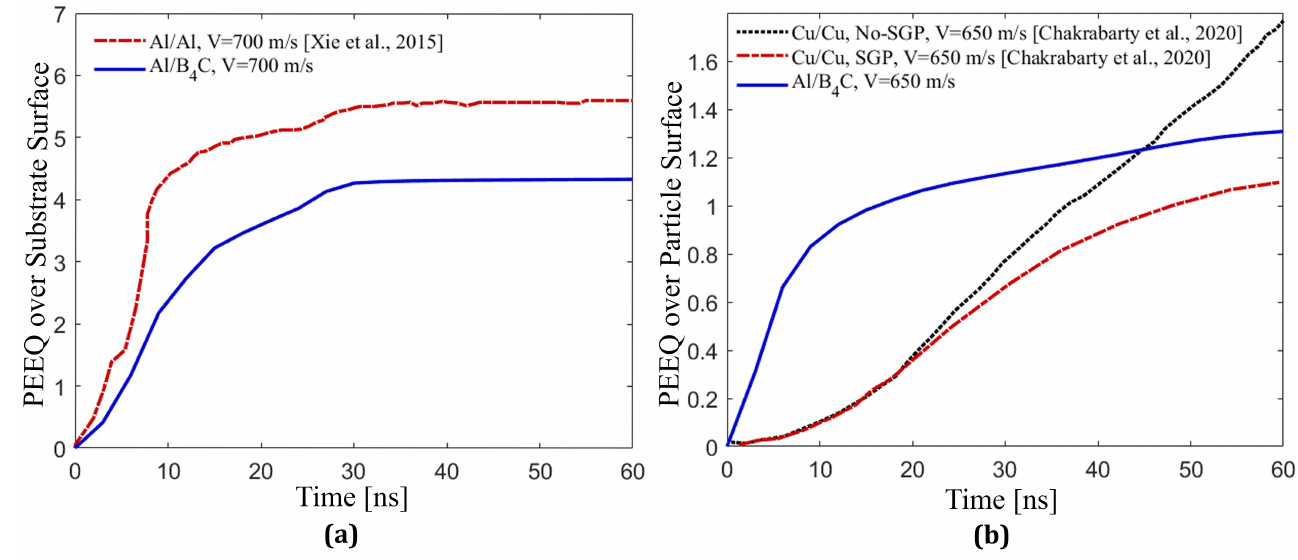
Figure 3. Comparison between the equivalent plastic strain (PEEQ) generated in the B 4 C particle and the Al substrate in this study and previous studies involving Al and Cu particles and Al and Cu substrates [44,45]. ( a ) The average PEEQ value over the Al contact-surface in an Al/B 4 C coating in the current study (Al/B 4 C, V = 700 m/s) and in Al/Al coating reprinted from the literature [44] (Al/Al, V = 700 m/s) with D Particle = 25 µ m and V Impact = 700 m/s is calculated using an Arbitrary Lagrangian–Eulerian (ALE) and Coupled Eulerian–Lagrangian (CEL) technique, respectively, in Abaqus. The GTN material model in the current study and the original Johnson–Cook (JC) model in the literature [44] are employed. ( b ) The average PEEQ value over the entire B 4 C particle in Al/B 4 C using the JHB model (Al/B 4 C, V = 650 m/s) and ALE technique, and over the entire Cu particle in Cu/Cu coating using the modified Johnson–Cook (JC) model with and without consideration of strain gradient plasticity (Cu/Cu, SGP, V = 650 m/s and Cu/Cu, No-SGP, V = 650 m/s) and CEL technique as reprinted from reference [45]. The calculations are performed with D Particle = 41 µ m and V Impact = 650